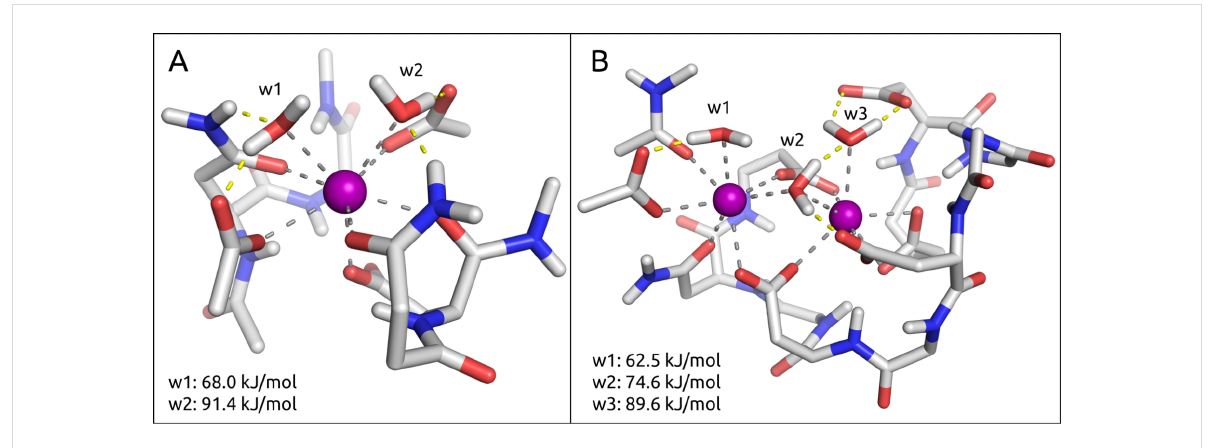
Figure 5: Model view of the binding site interactions of DC-SIGN ( E ) and BC2L-A ( H ) with water. A) The solvent exposed binding site of E illustrates two water molecules (w1 and w2) interacting with a single calcium ion, and the cost of desolvation for these waters. B) The buried binding site of H exhibits three water molecules (w1–3) bound to two calcium ions, together with their respective desolvation costs.